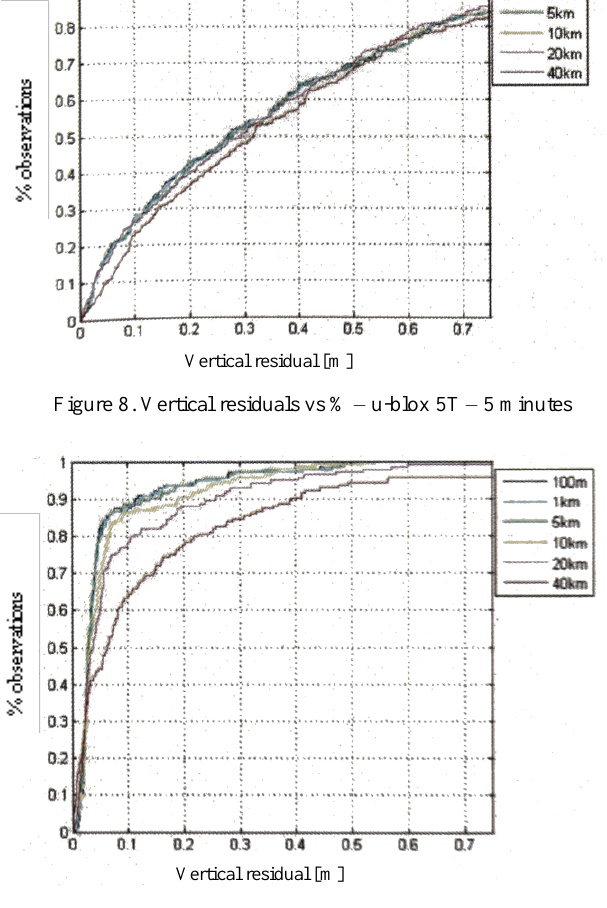
Figure 9. Vertical residuals vs % – u-blox 5T – 10 minutes